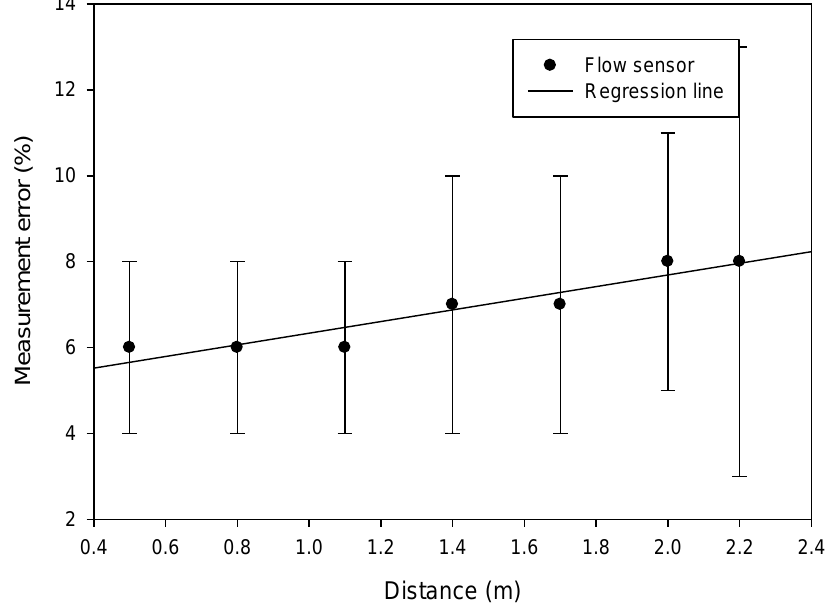
Figure 22. Measurement error of a WPWS equipped with a flow